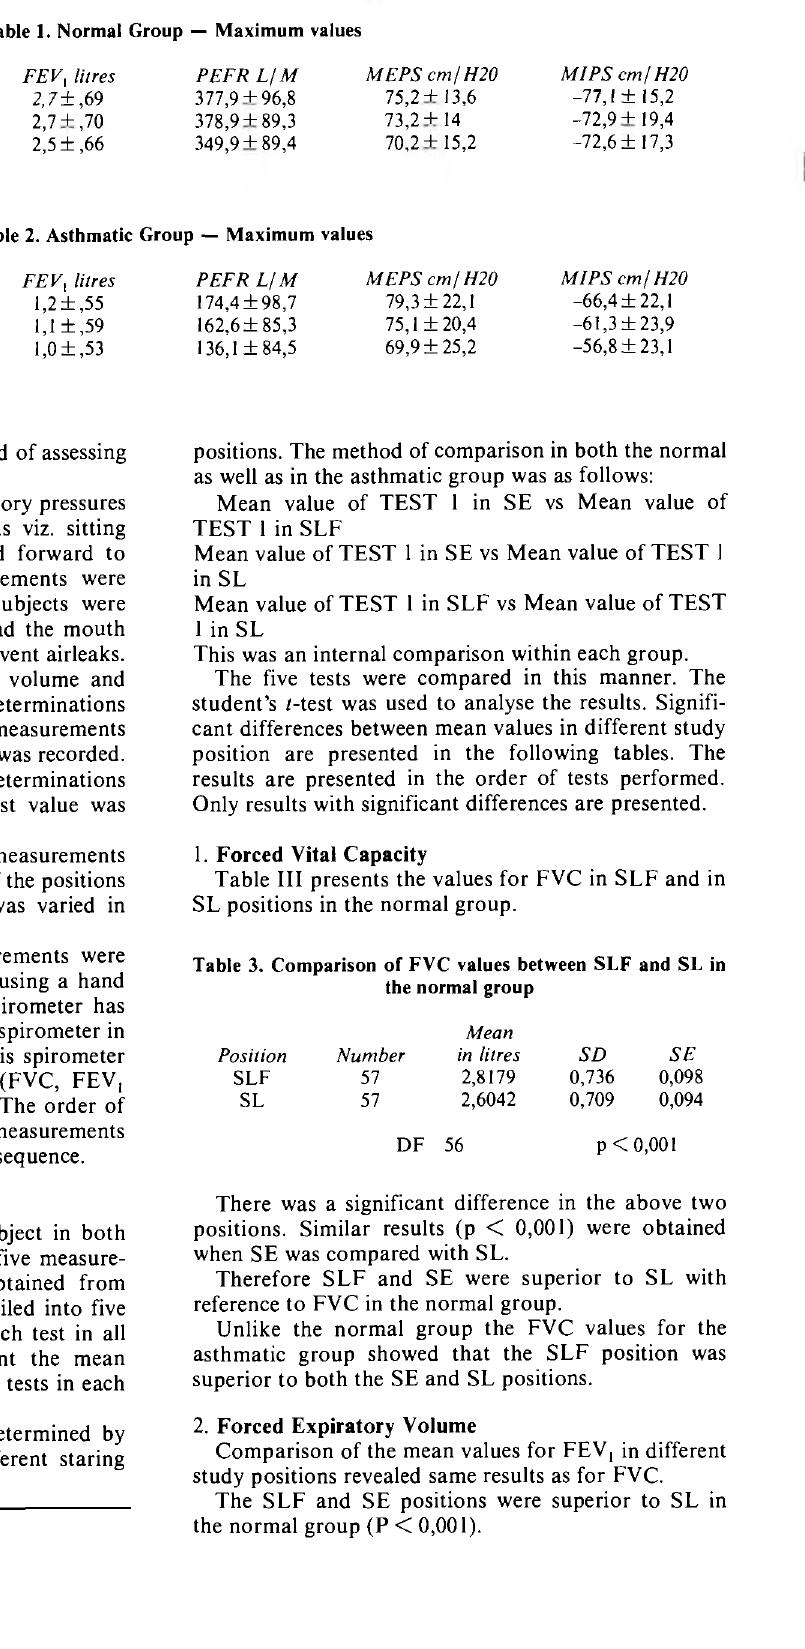
Table 1. Normal Group — Maximum values